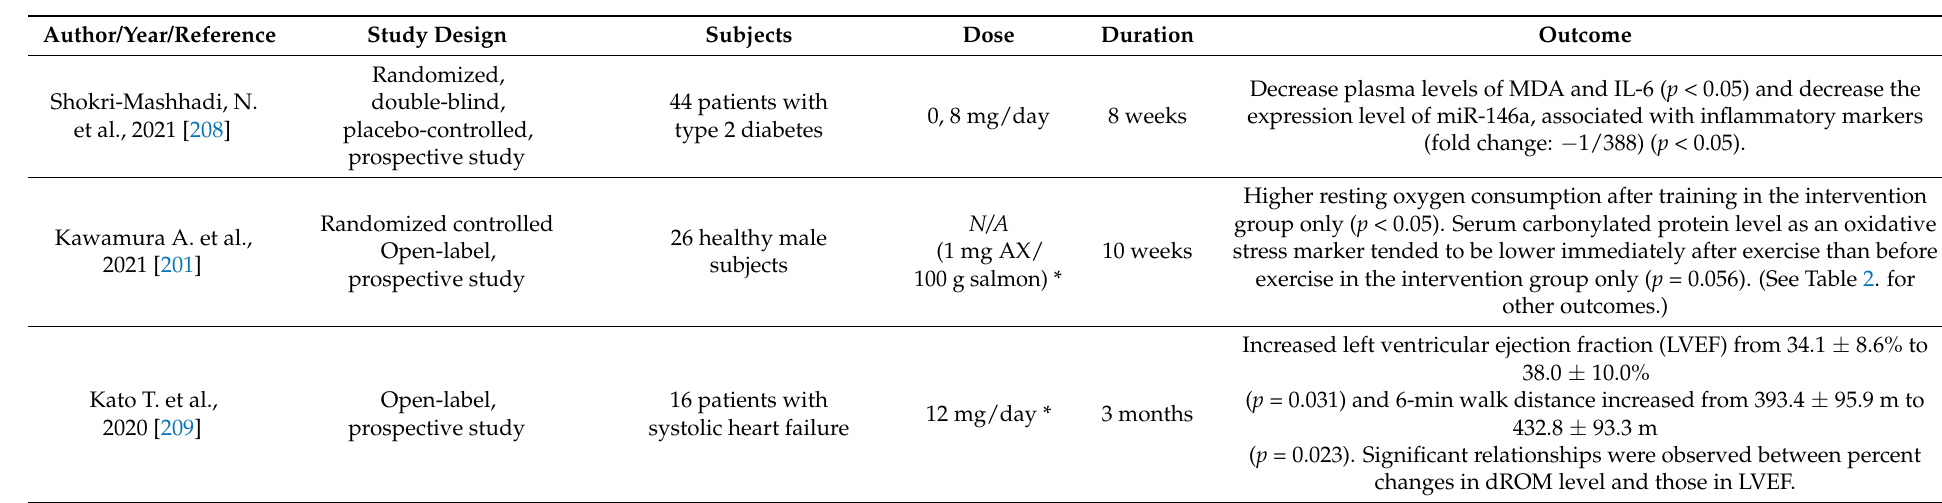
Table 3. Human clinical studies of AX on endocrinology, cardiovascular and